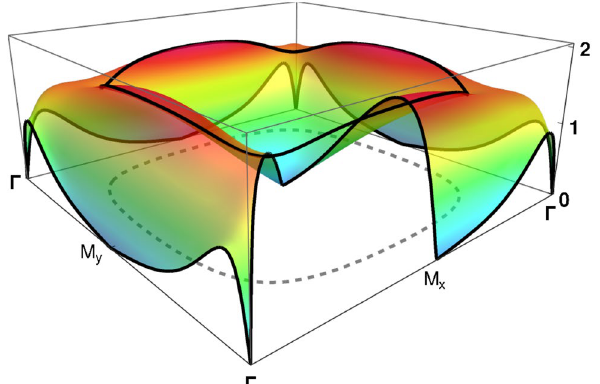
Fig. 3 Velocity v 𝐩 of the conduction band as a function of quasi- momentum p x , p y ∈ ( 0,2 𝜋 ) with dimension energy given in eV. The variable V = ( a 0 ∕ ℏ ) v has dimension m/s. In the special points Γ = ( 0, 0 ) , M = ( 𝜋 , 0 ) , X = ( 𝜋 , 𝜋 ) the band velocity 𝐕 = 𝜕𝜖 zero; 𝐏 = ( ℏ ∕ a 0 )